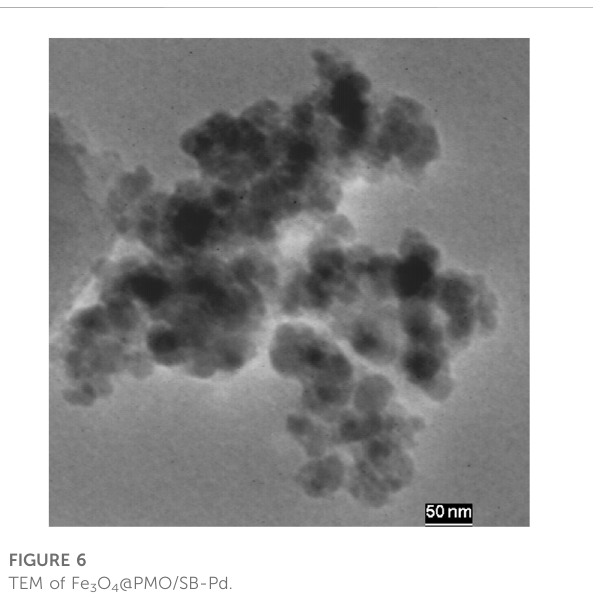
FIGURE 6 TEM of Fe 3 O 4